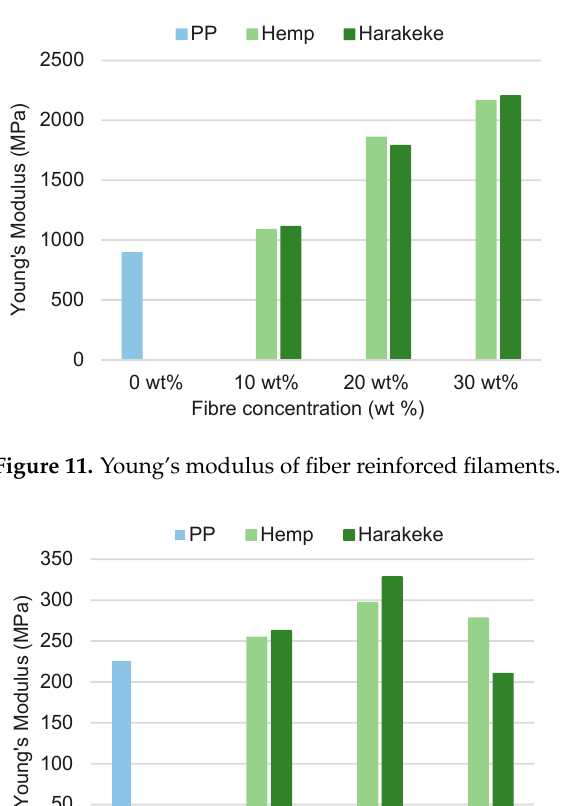
(a) PP Figure 13. (a) PP